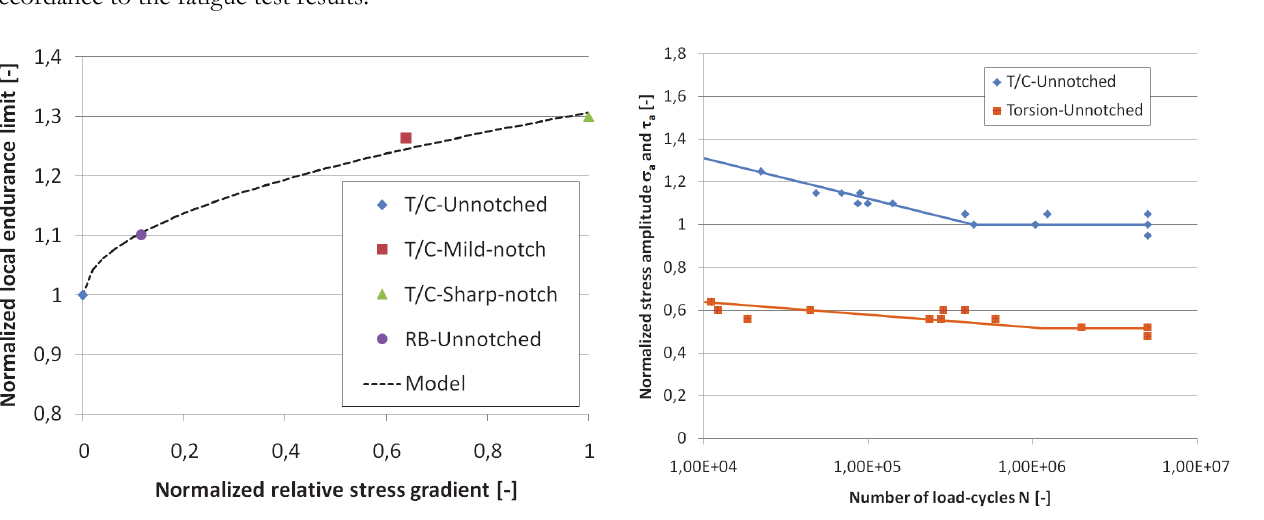
Figure 2. Assessment of local fatigue strength (50CrMo4). Figure 3. Comparison of T/C- and torsion loading